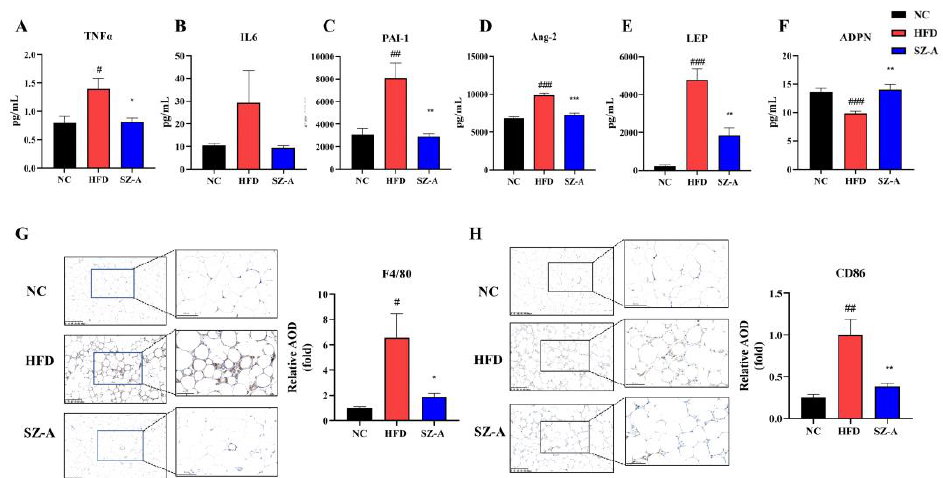
Figure 4. Inflammatory factors TNFα ( A ), IL6 ( B ), PAI-1 ( C ), Ang-2 ( D ), LEP ( E ) and ADPN ( F ) in the serum of the three groups of mice ( n = 6/group). Representative images of F4/80 ( G ) and CD86 ( H ) immunohistochemical staining of the eWAT (Scale bar, 100 µm, and 200 µm). The histograms indicate quantification of F4/80 or CD86 positive area per field ( n = 6/group). Values represent mean ± SEM. (# p < 0.05, ## p < 0.01, ### p < 0.001 HFD vs. NC and * p < 0.05, ** p < 0.01, *** p < 0.001 HFD vs. SZ-A).